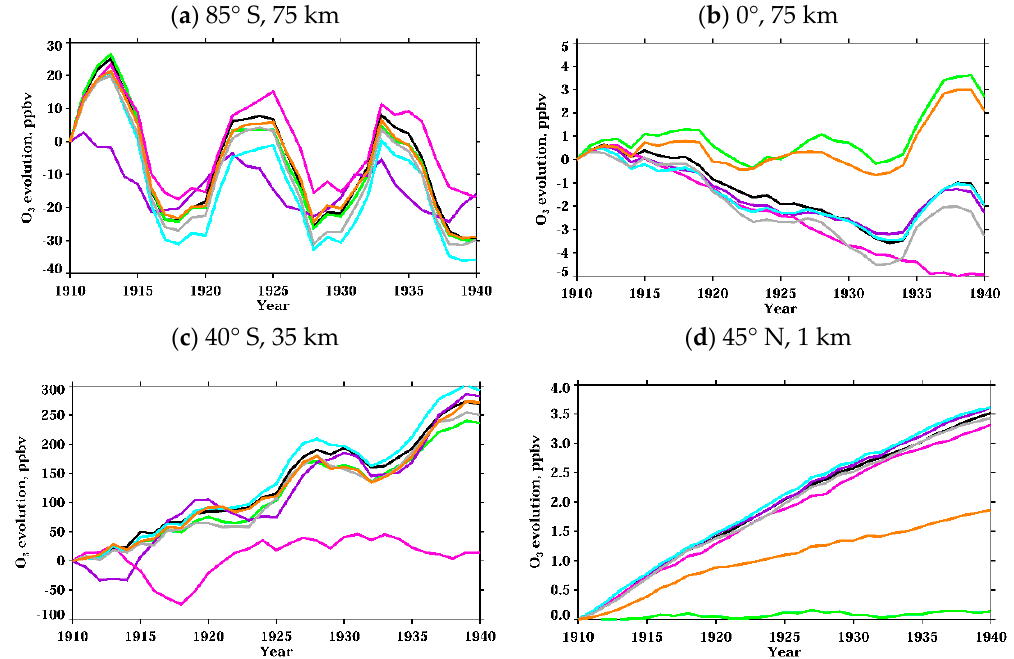
Figure 8. The evolution of annual zonal mean ozone mixing ratios since 1910. ( a ) In the southern polar upper mesosphere panel; ( b ) in the tropical mesosphere panel; ( c ) in the middle stratosphere over southern midlatitudes panel; and ( d ) in the the lower troposphere over northern midlatitudes panel. The lines are black for ALL, violet for noEPP, magenta for fixUV, light blue for fixVIS/IR, green for fixGHG, orange for fixWMGHG, and grey for noVOL experiments.